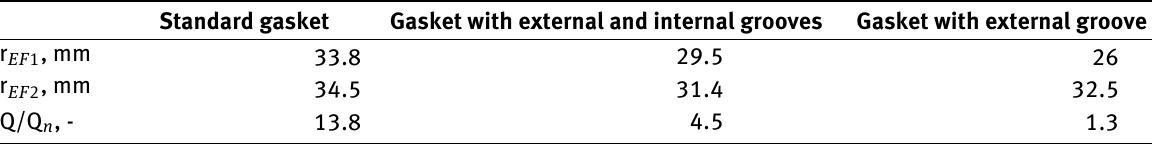
Table 1: Relative leakage based of effective (width) radii of the particular gasket